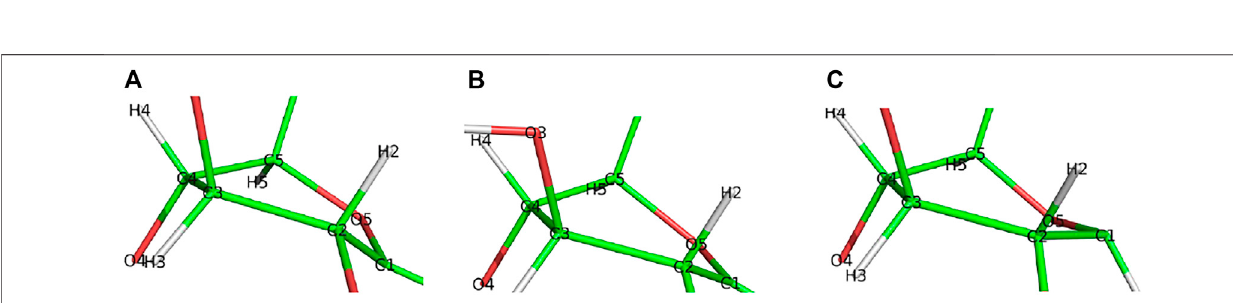
Frontiers in Chemistry |